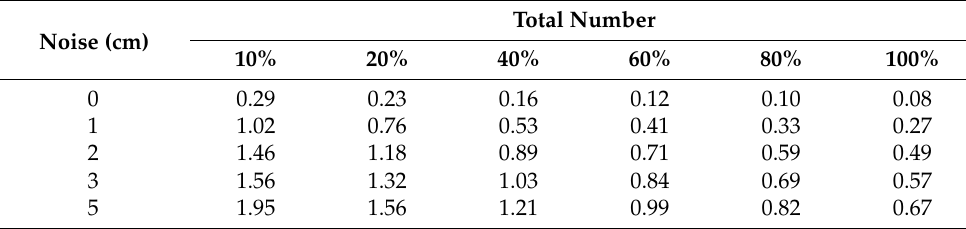
Figure 9. The cumulative absolute error curves under different noise levels. Table 3. The value of the cumulative absolute error under differernt noise levels.